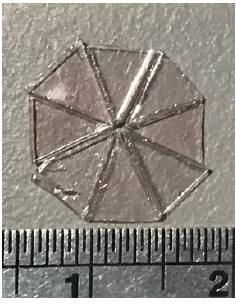
Figure 5. A prototype of holographic radial polarization converter (HRPC).